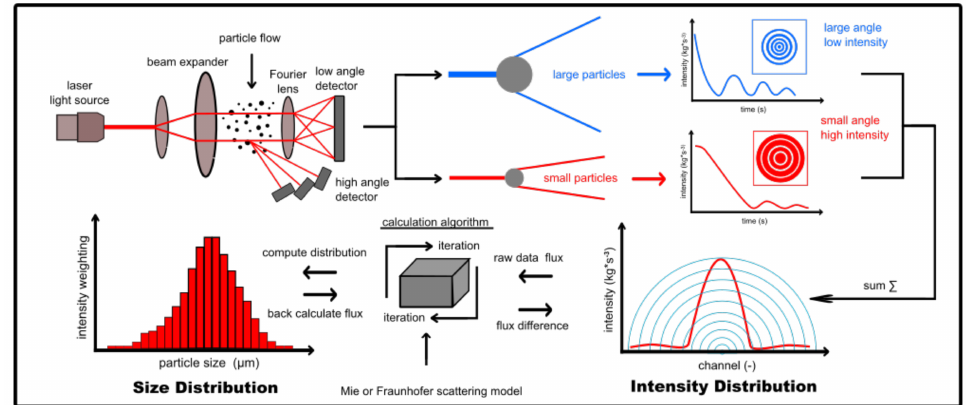
Figure 6. Schematic diagram of a laser diffraction setup with subsequent data